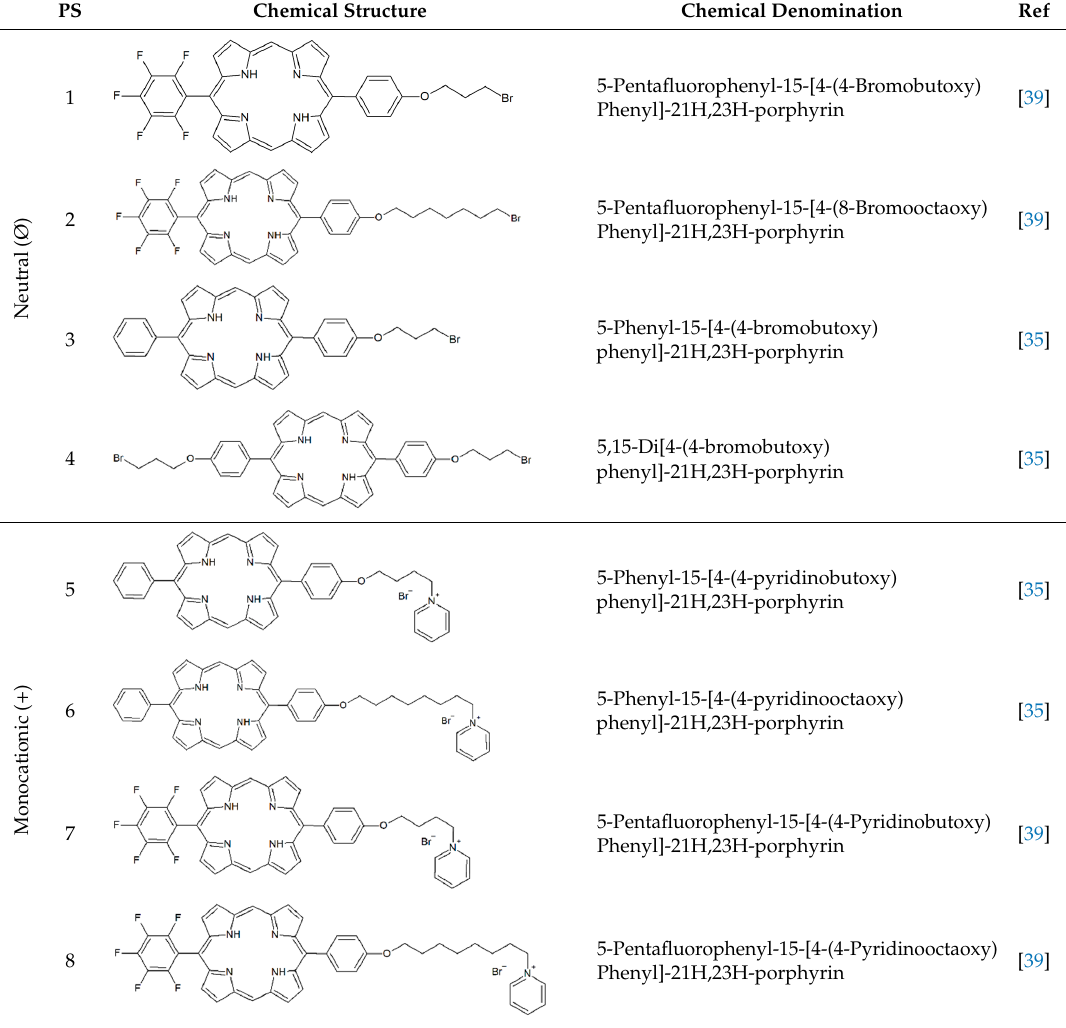
Figure 1. Visible light absorption spectra of the diaryl-porphyrins ( 1 – 11 ).